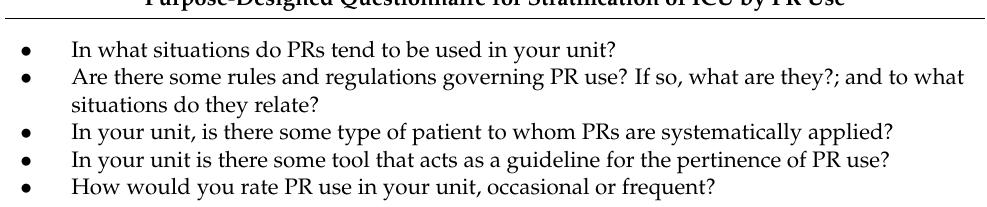
Table 2. Purpose-designed questionnaire for the stratification of intensive/critical care units by PR use.